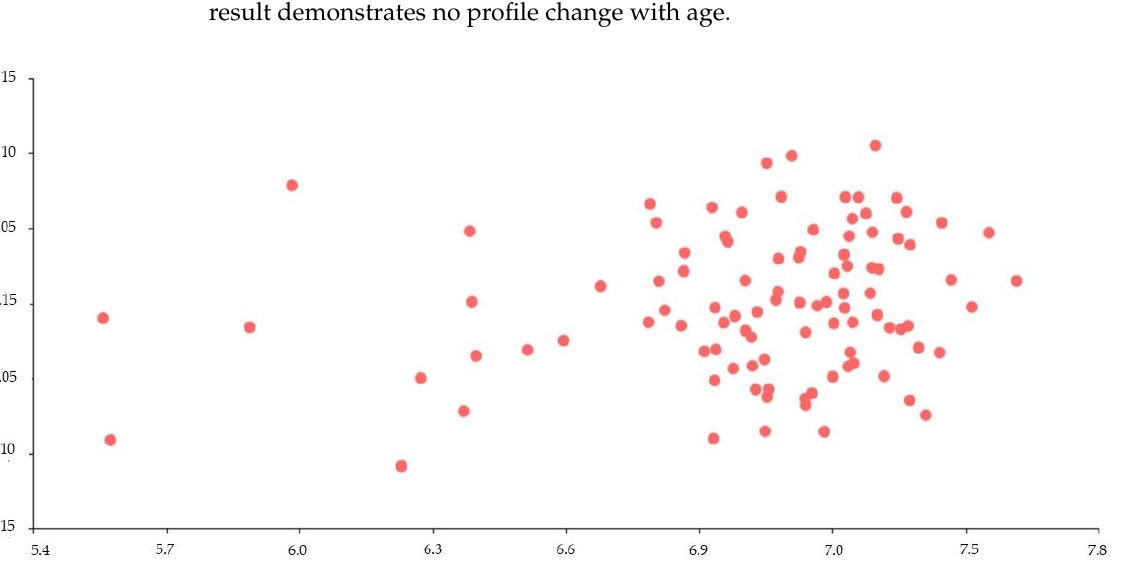
Table 2. Two-way NPMANOVA test did not reflect statistically significant differences between the three sex groups studied (F = 0.012; p = 0.707) nor between the differences in ages (F = 0.015; p = 0.512). Sum of Degrees of Source Mean Square F p Squares Freedom Sex 3.60 × 10 24 2 1.80 × 10 24 0.012022 0.7078 Age 7.31 × 10 25 31 2.36 × 10 24 0.015751 0.5212 Interaction − 3.14 × 10 26 62 − 5.06 × 10 24 − 0.033799 0.8221 Residual 4.49 × 10 26 3 1.50 × 10 26 Total 2.12 × 10 26 98